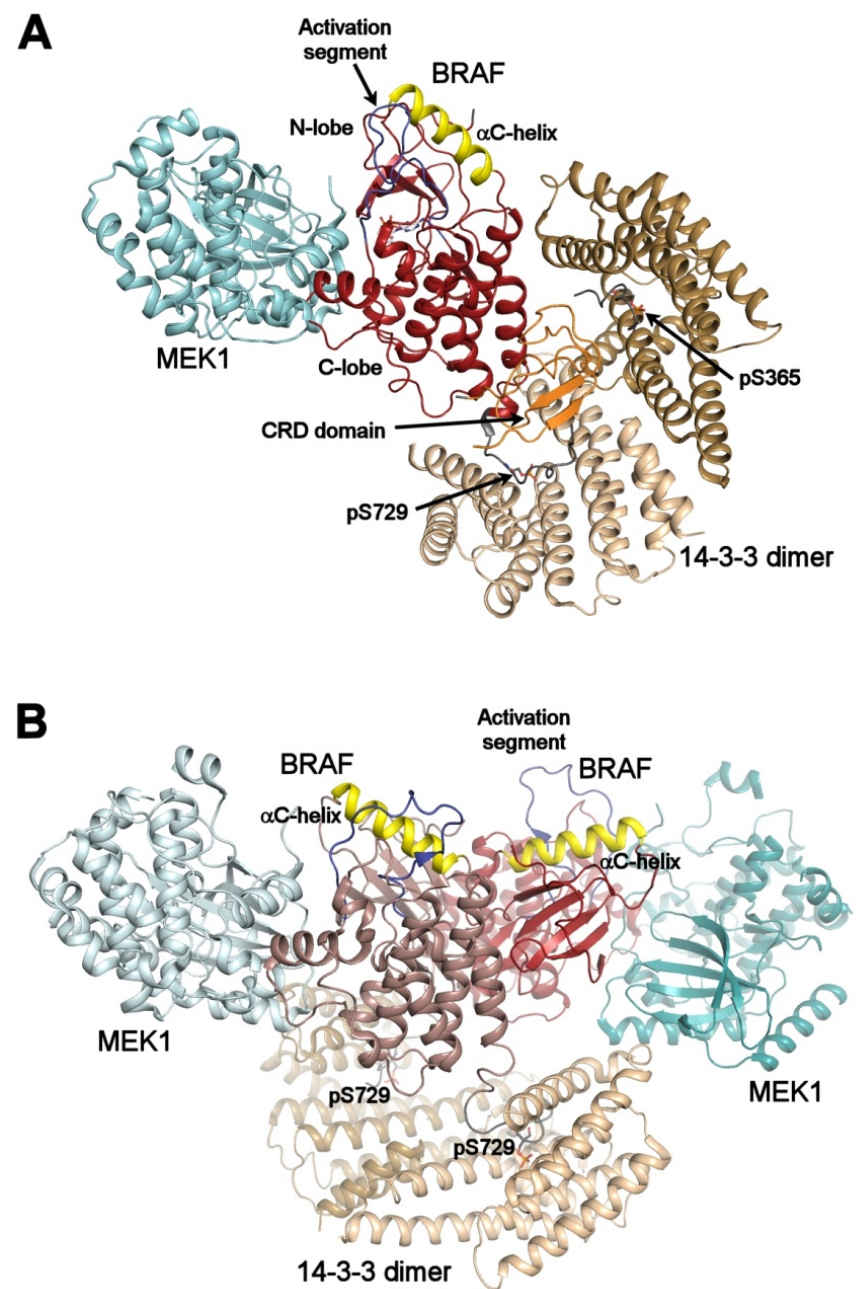
Figure 3. Autoinhibited and active B-RAF:MEK1:14-3-3 complexes. ( A ) structure of the autoinhibited BRAF:MEK1:14-3-3 complex (PDB ID: 6NYB [6,7,24,26]). The 14-3-3 dimer simultaneously binds both pSer 365 and pSer 729 motifs (shown in gray) bordering the B-RAF kinase domain (shown in dark red). The CRD domain (shown in orange) is sequestered within the central channel of the 14-3-3 dimer. The position of the α C-helix (shown in yellow) and the activation segment (shown in blue) correspond to the autoinhibited state. The 14-3-3 protein inhibits B-RAF by blocking its membrane localization dimerization through steric occlusion; ( B ) structure of the active B-RAF:MEK1:14-3-3 complex (PDB ID: 6Q0J [6,7,24,26]). Dephosphorylation of the N-terminal motif (pSer 365 ) causes structural rearrangement resulting in an active B-RAF dimer stabilized by the 14-3-3 dimer through anchoring C-terminal pSer 729 motifs of two B-RAF molecules. The B-RAF kinase domains are oriented in the back-to-back fashion with the α C-helix in a position consistent with the active conformation. The figure was prepared with PyMOL (https: // pymol.org / 2 /